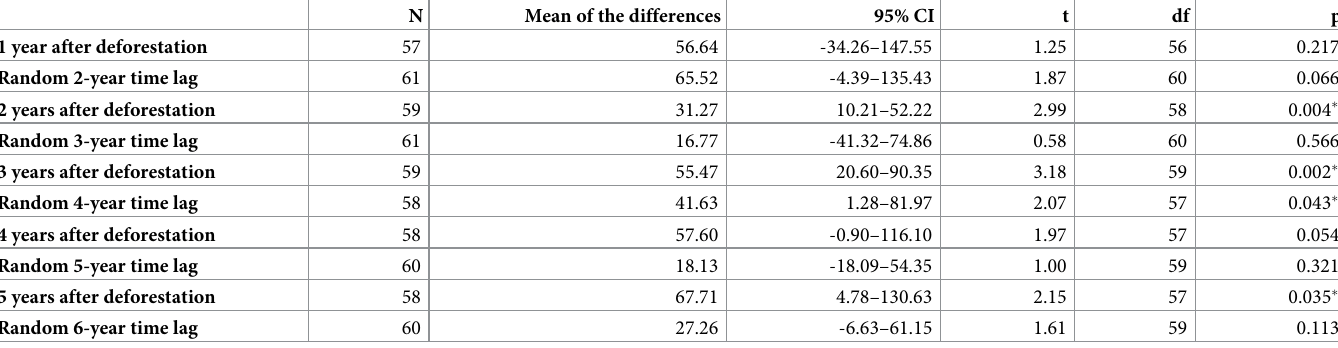
Table 3. Paired samples t -tests for dengue incidence 1 year before and 1–5 years after deforestation and corresponding random years.